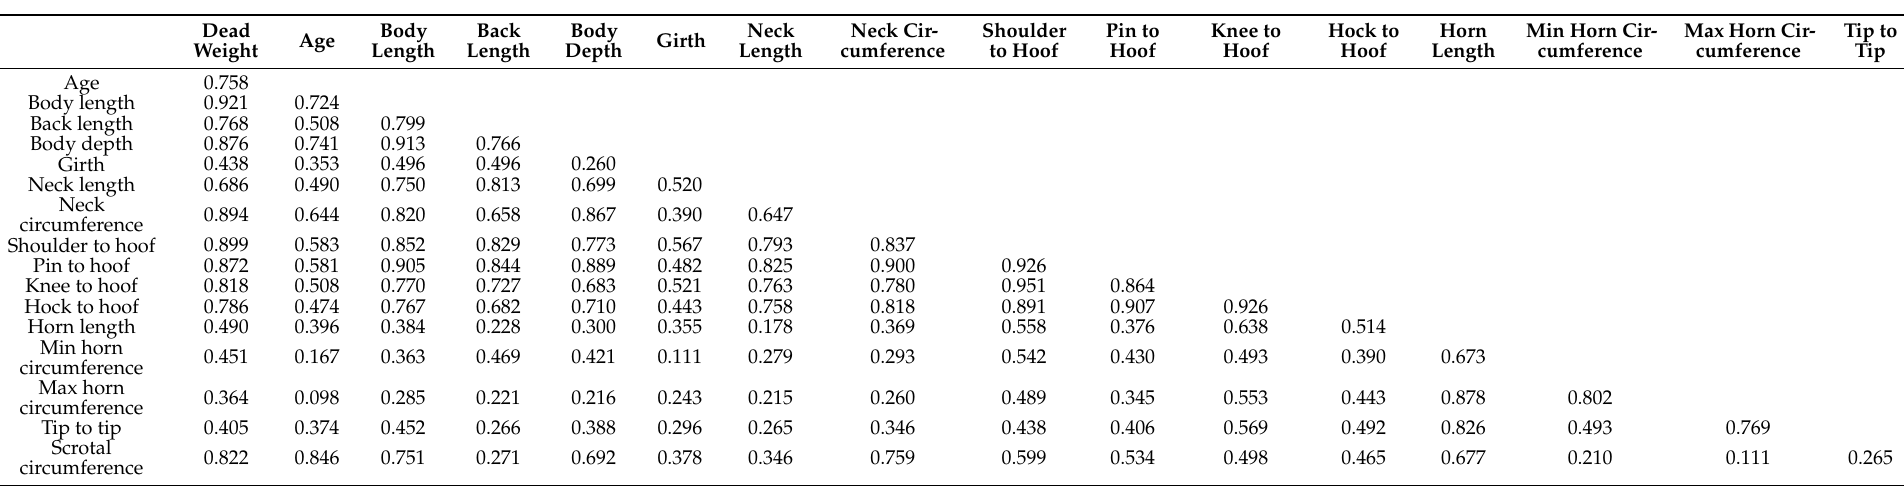
Table 2. Pearson Correlation coefficients (r) of the body and measurements of ~3.7-year-old giraffe ( G. c. angolensis